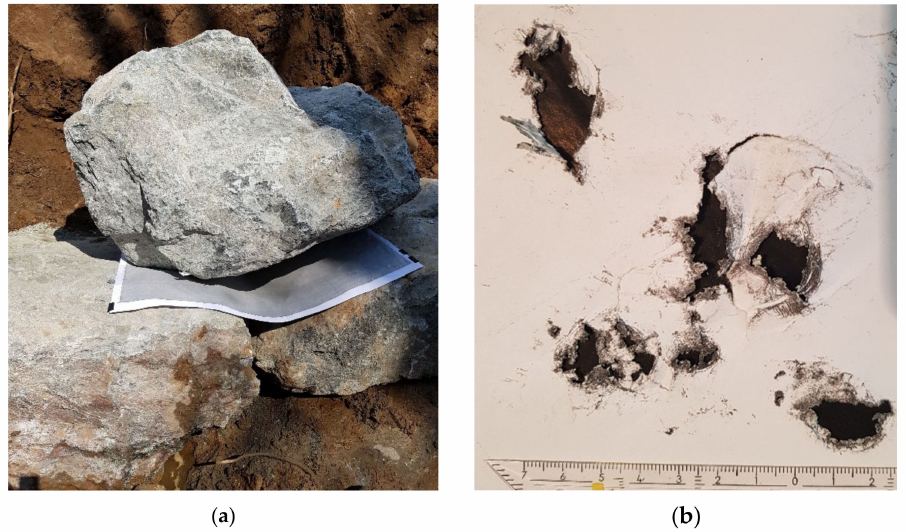
Figure 5. Piled stones to investigate the contact area using graphite paper ( a ) and prints of the contact areas, scale bar in cm ( b